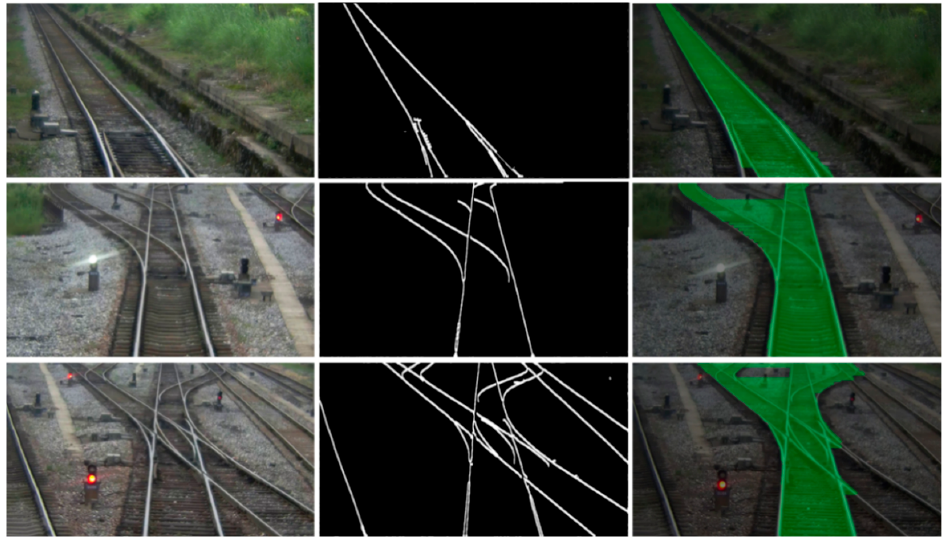
Figure 16. Multiple turnout track lines and track region extraction.